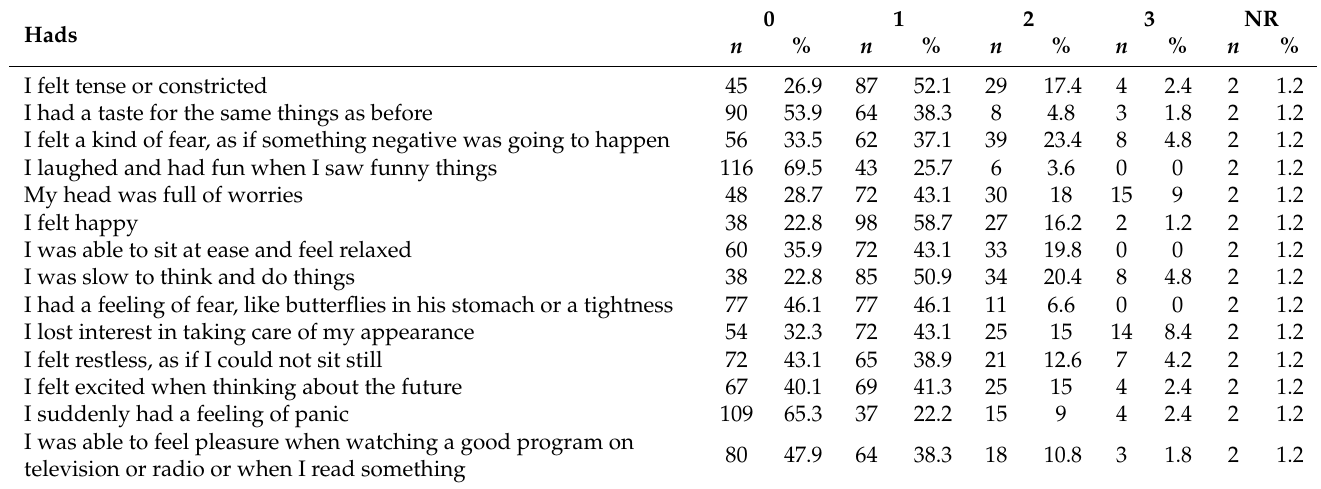
Table 3. Frequency of responses to HADS items.